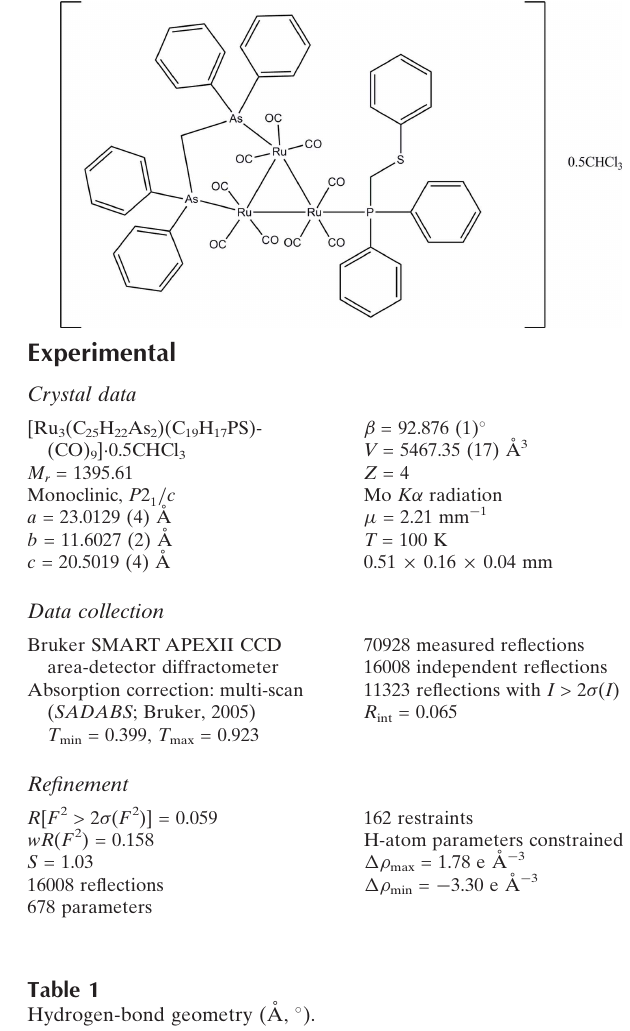
Hydrogen-bond geometry (A˚ , (cid:3)